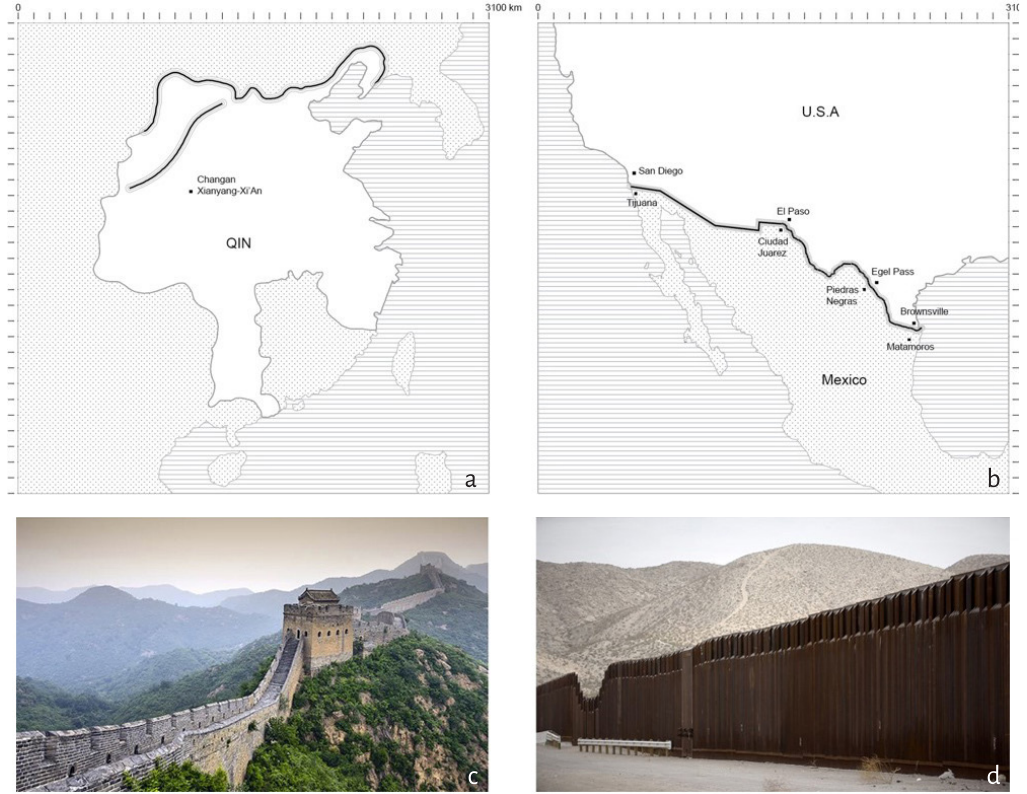
Fig. 3 Map of Qin Dynasty extension 221-206 a.C. (a). USA / Mexico border wall map (b). Building technique: Great Wall of China (c). Tijuana Wall ; photo by Martine Bureau; video project Wall of Disorder